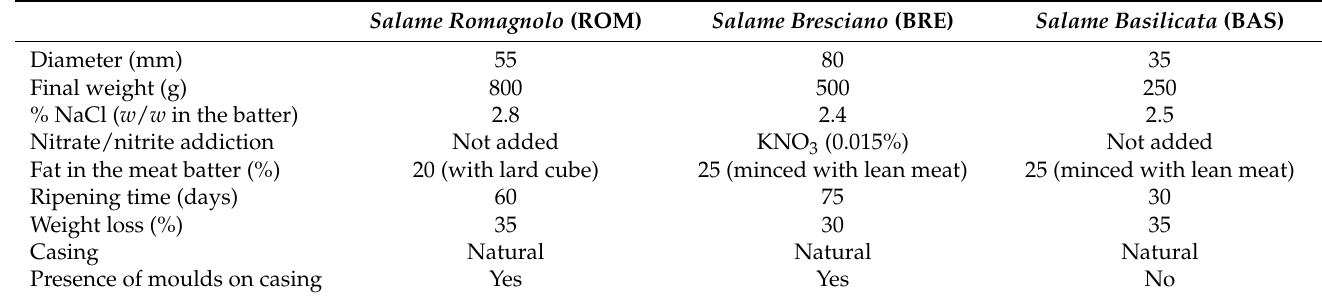
Table 1. Main characteristics of the fermented sausages used for the isolation of LAB strains. Salame Romagnolo